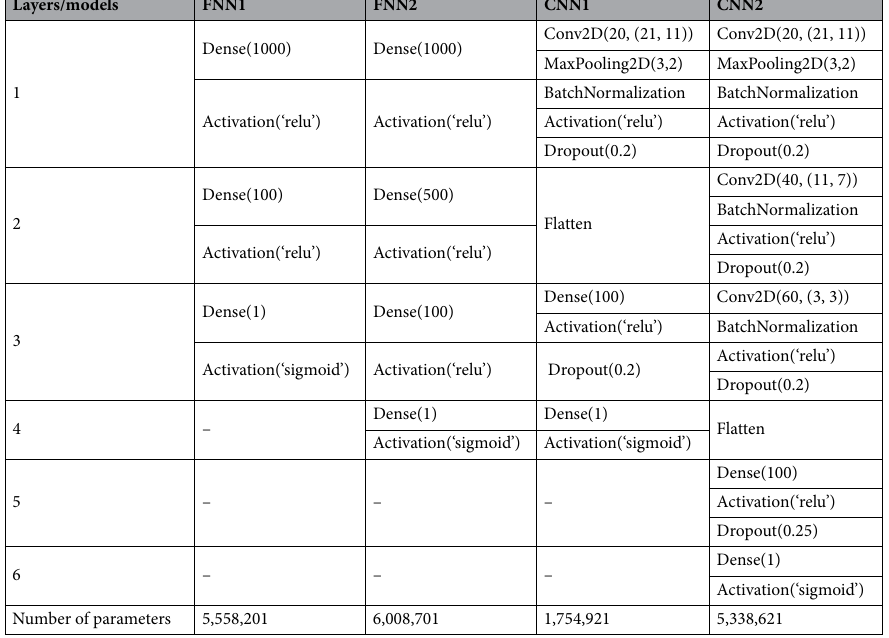
Table 2. The structures for the FNN and CNN models. The symbol “–” means the layer does not exist and Dense(1000) means fully connected layer with 1000 nodes. Conv2D(20, (21, 11)) means a 2D convolutional layer with 20 filters, where the size of each filter is 21 in the frequency direction and 11 in the pressure direction. MaxPooling2D (3,2), is a 2D max-polling operator with size 3 in the frequency direction and 2 in